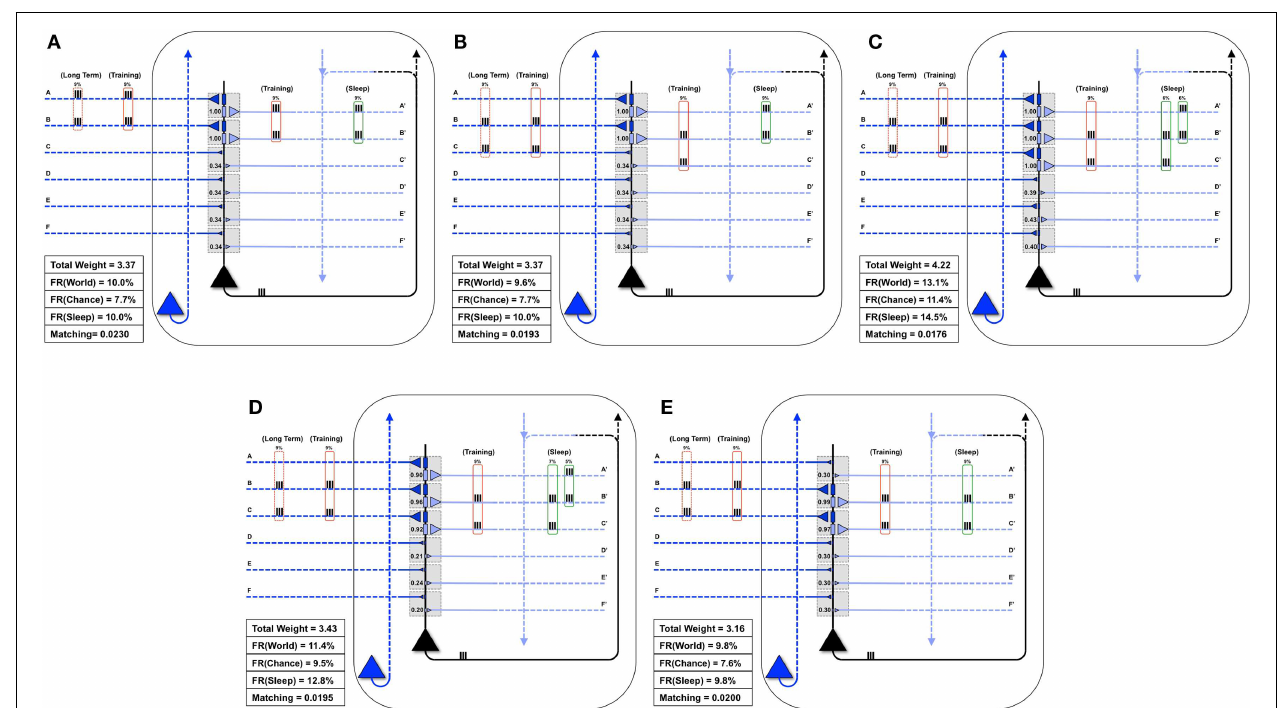
synapses A/A (cid:48) , B/B (cid:48) , and C/C (cid:48) are best protected, and Matching slightly improves. However, after a single wake/sleep period, the connection of synapses A/A (cid:48) has not yet been “forgotten.” (E) During subsequent wake/sleep cycles, synapses B/B (cid:48) and C/C (cid:48) are potentiated again during wake, while synapses A/A (cid:48) are not.Thus, synapses A/A (cid:48) continue to exhibit progressive depression during down-selection in sleep. After multiple wake/sleep cycles, synapses A/A (cid:48) are depressed to the same level as synapses D/D (cid:48) , E/E (cid:48) , and F/F (cid:48) .Thus, Matching improves further as the strong connections for A/A (cid:48) are